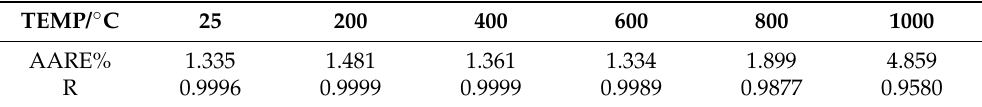
Table 3. Comparison of high temperature tensile finite element simulation and experimental results of Q235B material.